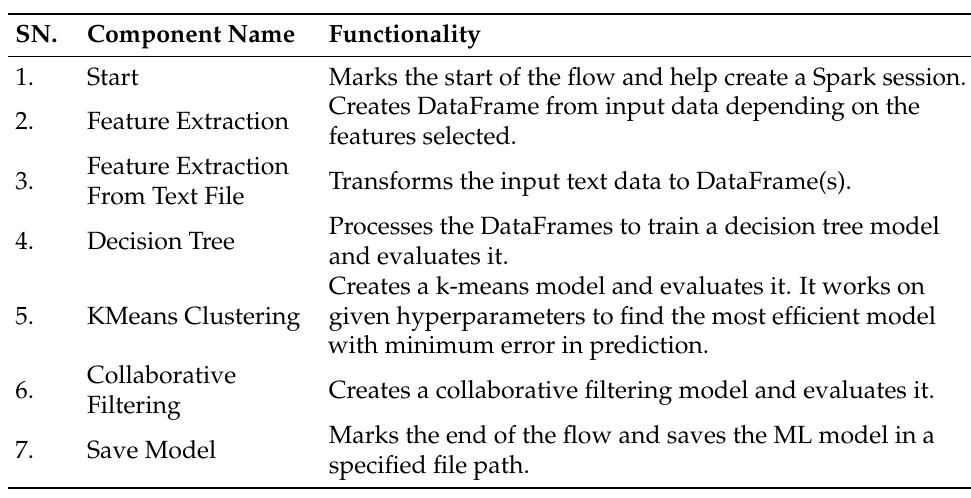
Table 1. Supported graphical ML components with their